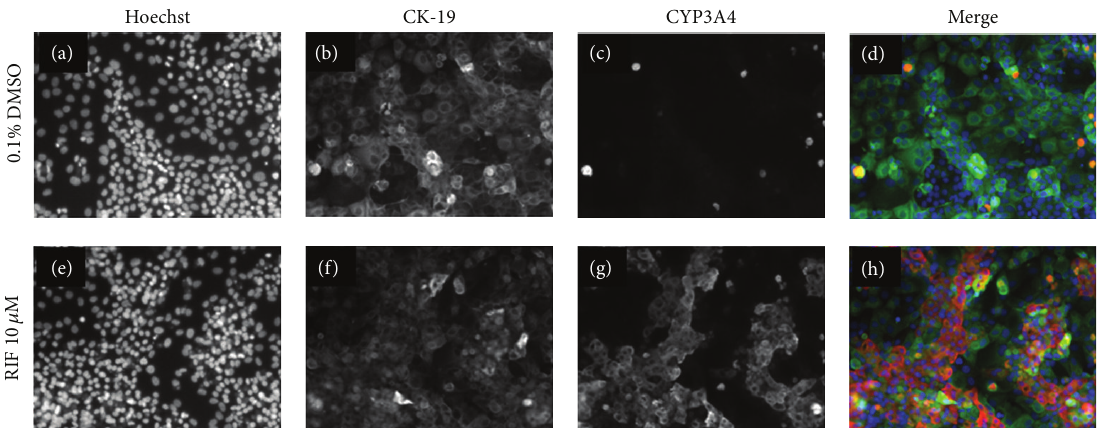
Figure 5: Multiplexed staining of cryopreserved HepaRG cells seeded at 50,000 cells per well and treated with DMSO vehicle control or 10 𝜇 M rifampicin. (a) and (e): DMSO and rifampicin-treated cells, respectively, stained with Hoechst 33342 nuclear stain; (b) and (f): DMSO and rifampicin-treated cells, respectively, stained with anti-CK-19 antibody; (c) and (g): DMSO and rifampicin-treated cells, respectively, stained with anti-CYP3A4 antibody; (d) and (h): merged images of (a–c) and (e–g),